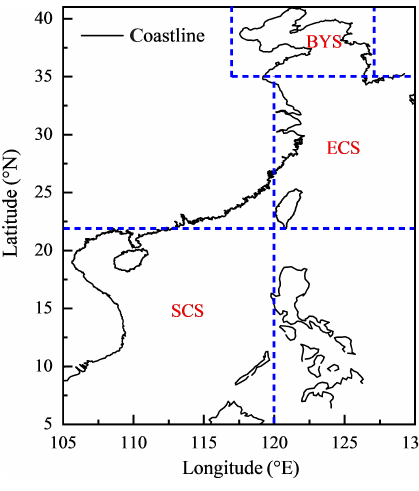
Figure 10. Study regions defined in this paper. teristics as higher in the southwest and lower in the north- east, which is affected by the ocean circulation. In addition, as can also be seen in Fig. 6, in the low-latitude region, the SST range of change in different months is relatively small, between 27 and 33 ◦ C, the change range of 5 to 6 ◦ C. In the high-latitude region, the SST can be less than 3 ◦ C at the low- est and greater than 15 ◦ C at the highest, with a relatively large variation of more than 12 ◦ C.